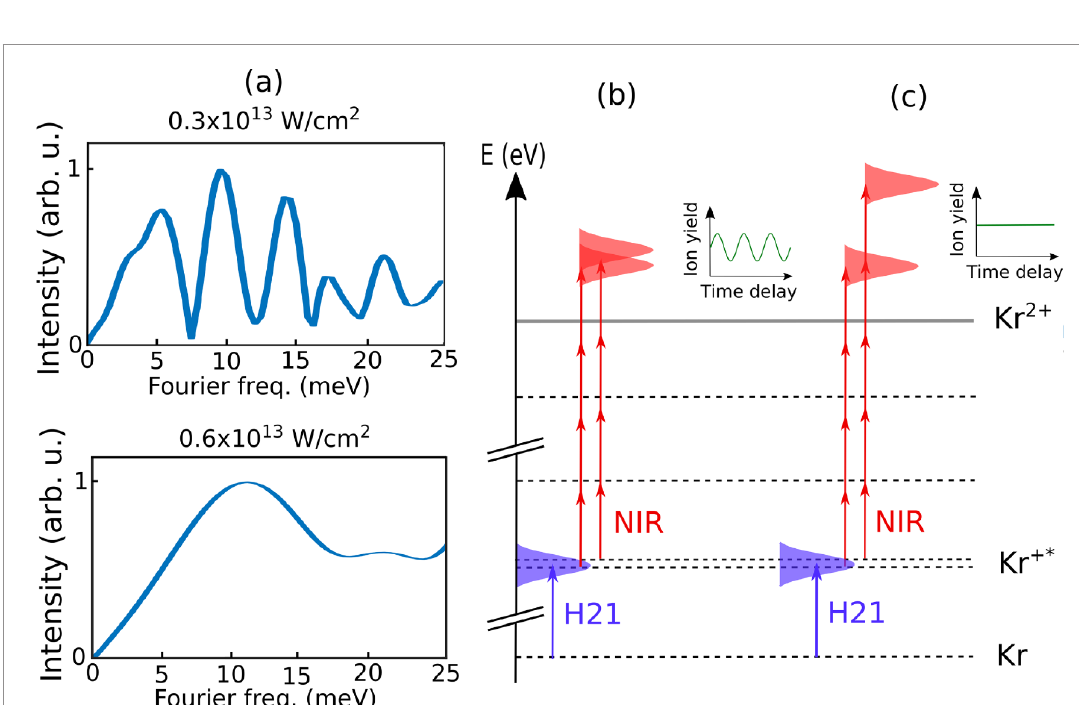
Figure 4. The Fourier analysis (blue solid lines) of the quantum beat oscillations (a) in the Kr 2 + ion yields obtained with HH21 and NIR intensities of 0 . 3 × 10 13 (figure 3(a)) and 0 . 6 × 10 13 Wcm − 2 (figure 3(b)). Illustration of the origin of the quantum beat oscillation in Kr + ∗ excited with HH21 at low NIR intensity (b) and at higher NIR intensities (c).